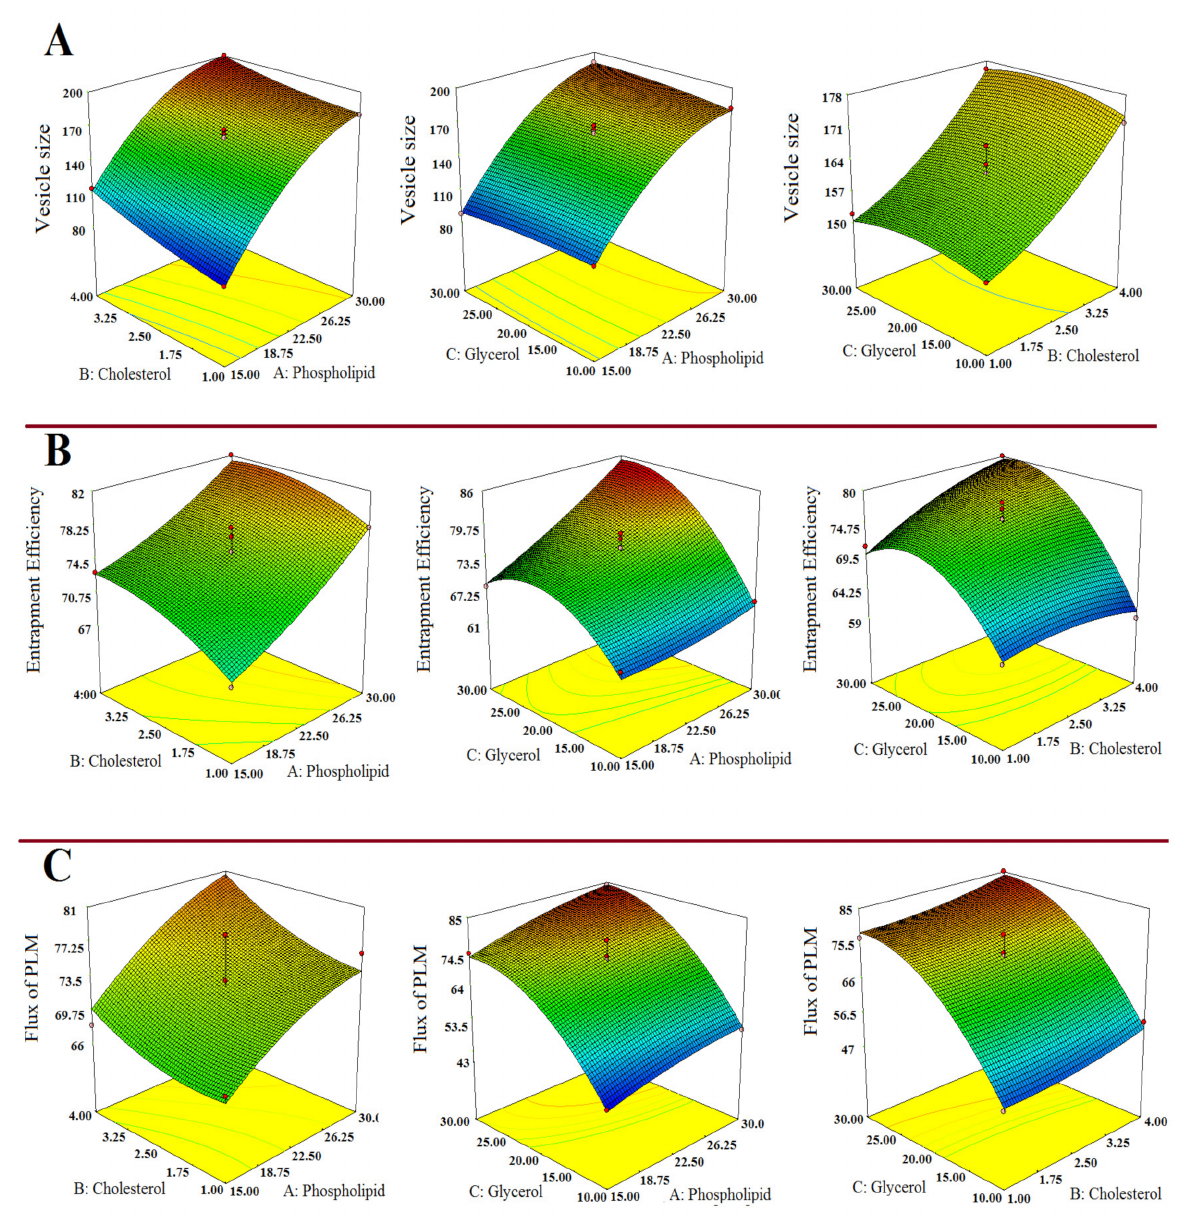
Figure 1. Response surface morphological plots indicating the comparative effects of independent variables, i.e., Phospho- lipid conc. (mg); Cholesterol conc. (mg); and Glycerol conc. (% w / v ) on ( A ) Vesicles size, ( B ) % Entrapment efficiency and ( C ) Flux of